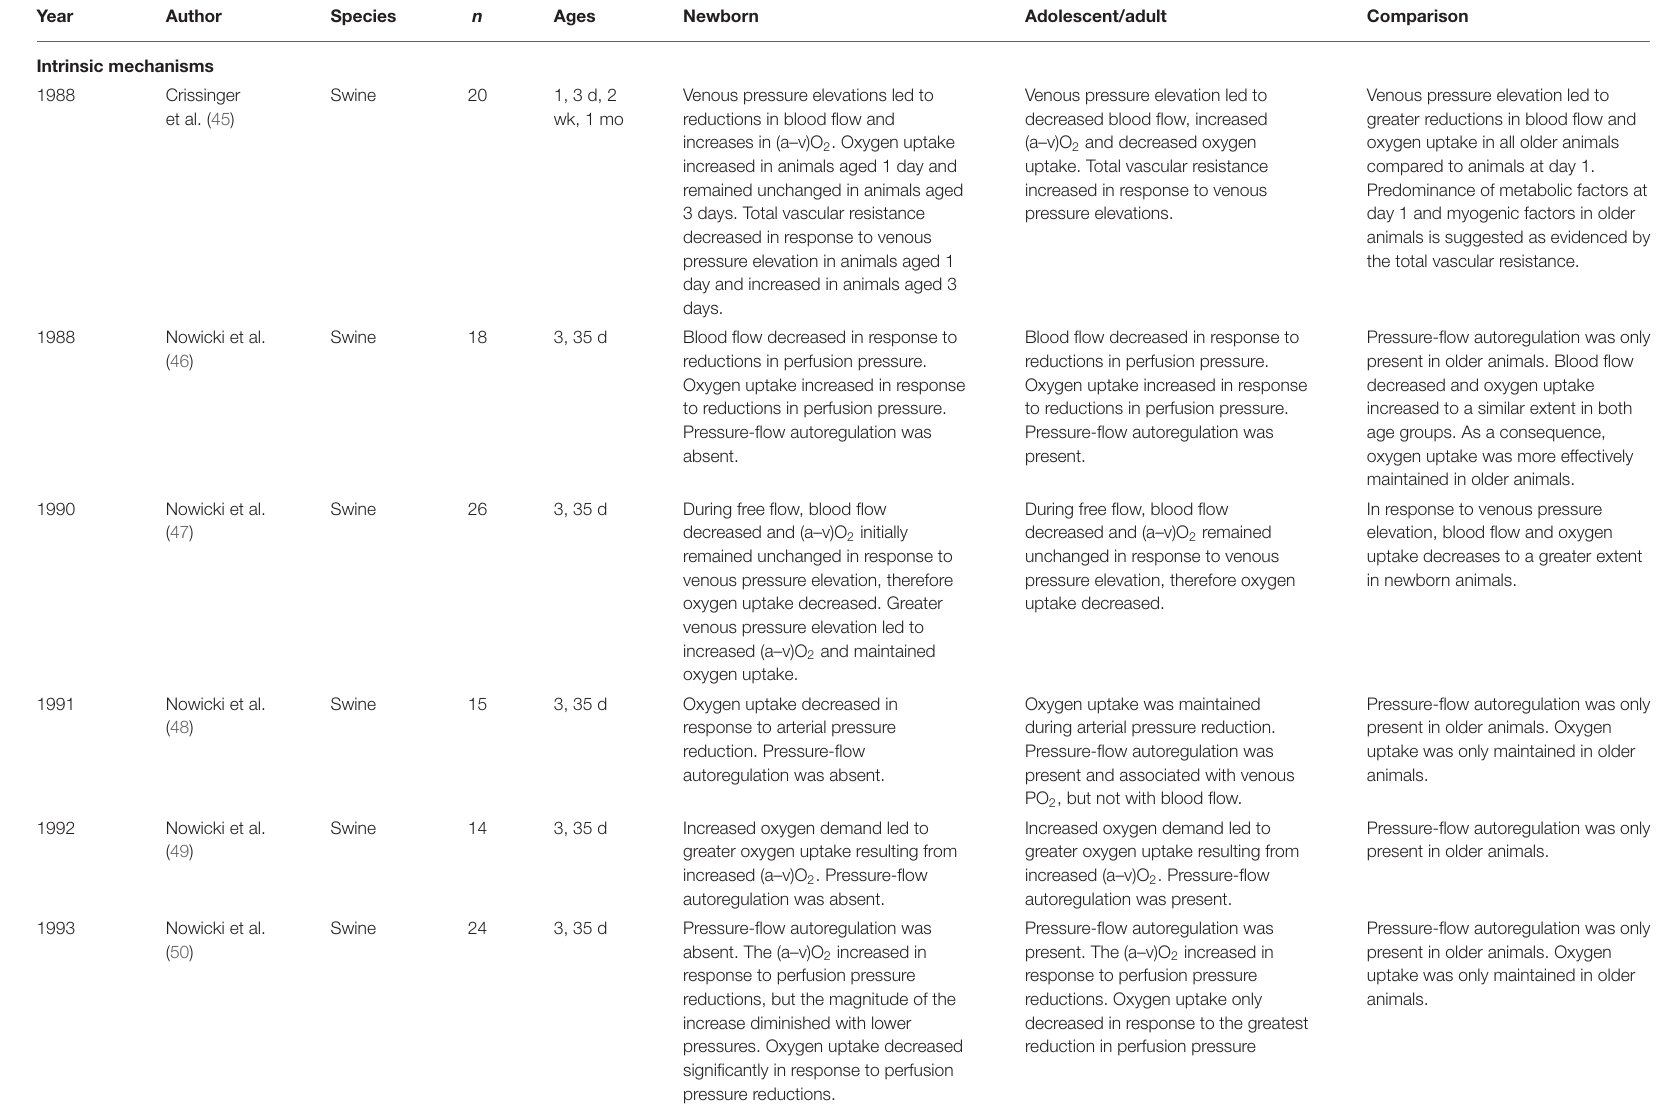
TABLE 2 | Postnatal maturation of intestinal oxygenation